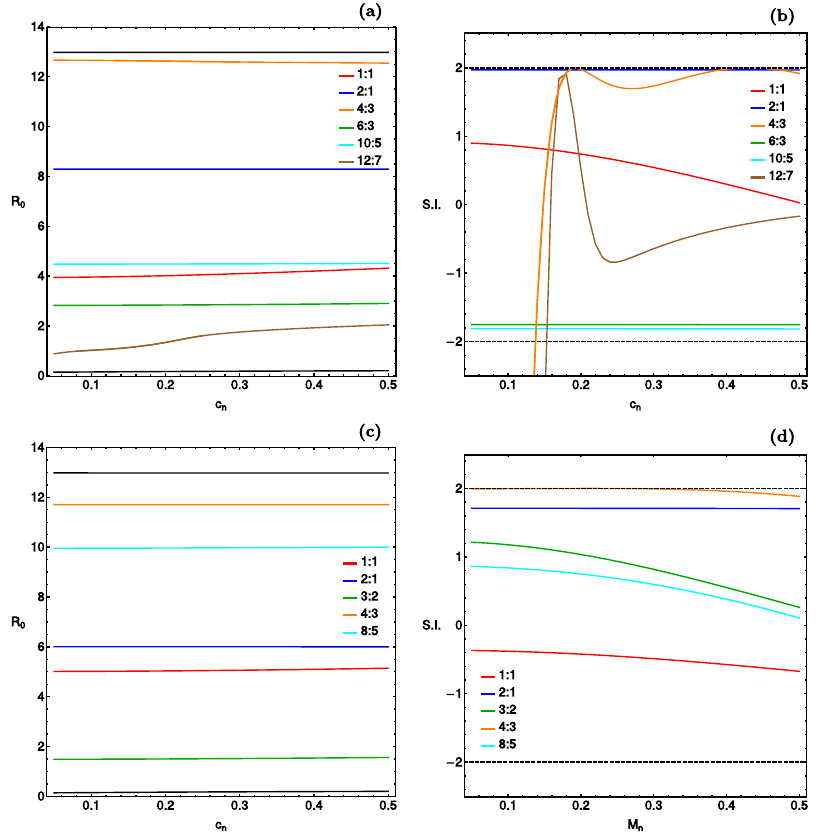
Fig. 2. Evolution of the R coordinate of periodic orbits as a function of the scale length of the nucleus, c n , for the PH models (panel a) and OH models (panel c), and the evolution of the stability index S.I. as a function of c n for the PH models (panel b) and OH models (panel